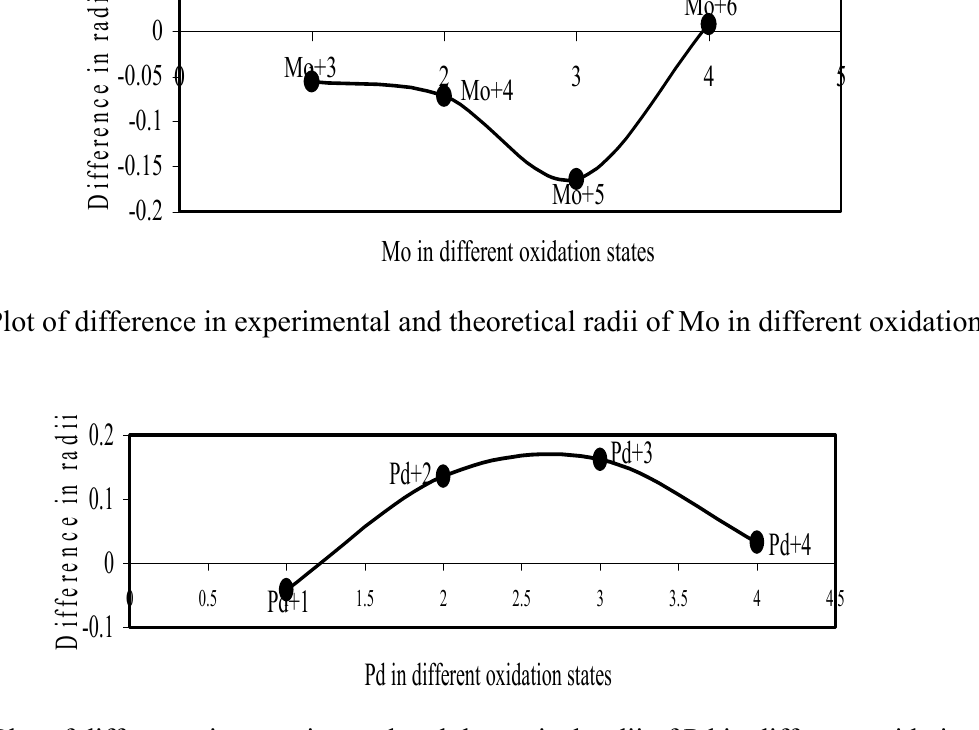
Figure 20. Plot of difference in experimental and theoretical radii of Pd in different oxidation states.